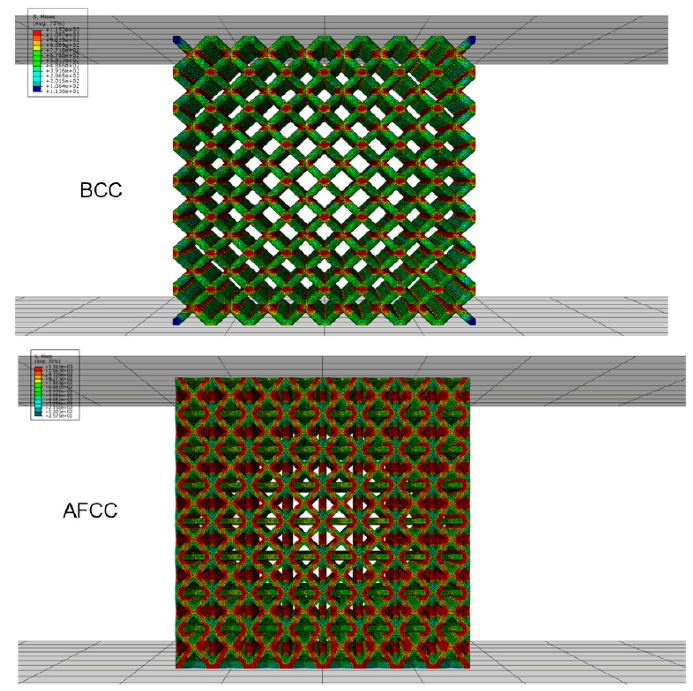
Figure 7. Stress nephogram of AFCC and BCC lattice structure. Materials 2018 , 11 , x FOR PEER REVIEW